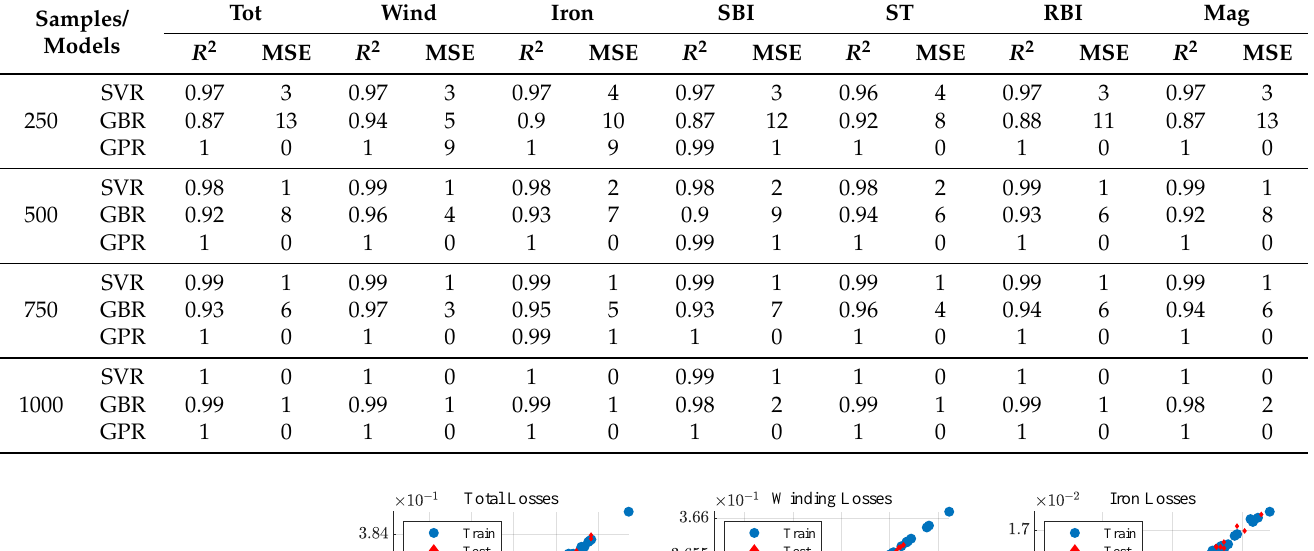
Table 6. Machine learning models performance to predict motor losses